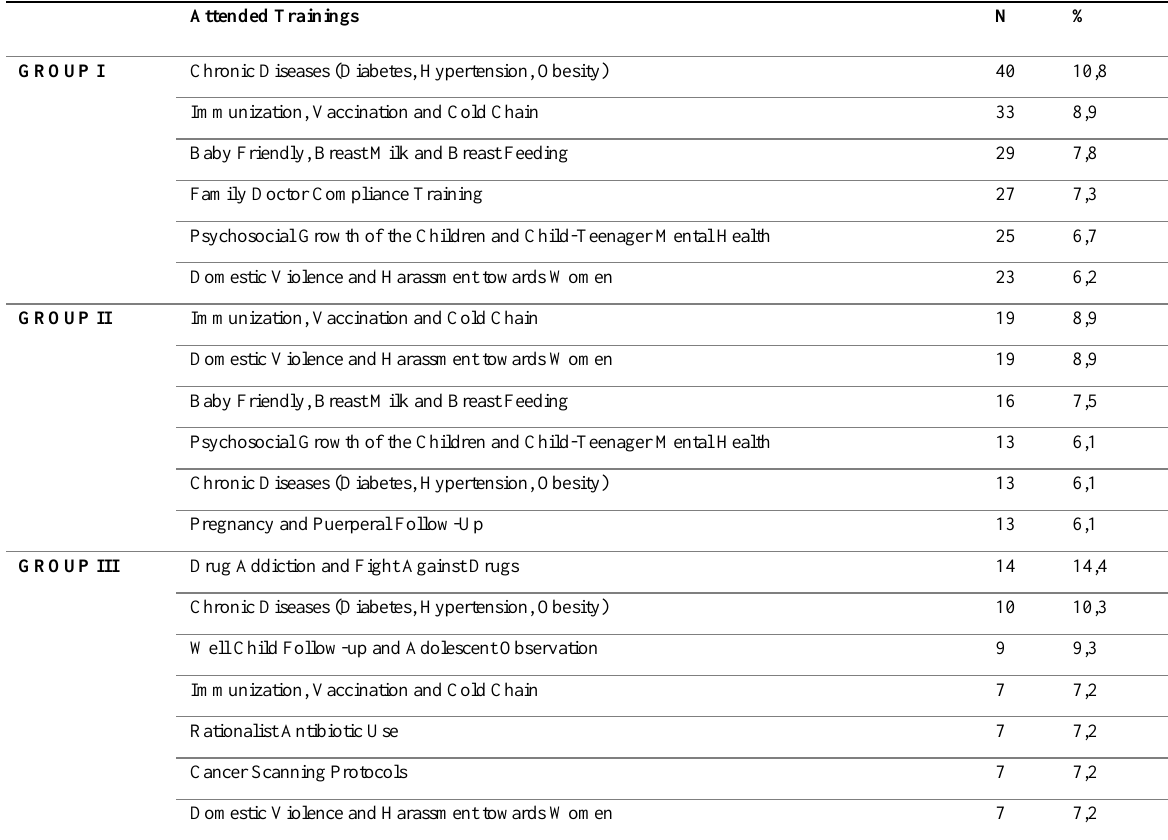
Table 10: Attended Service Training Subjects